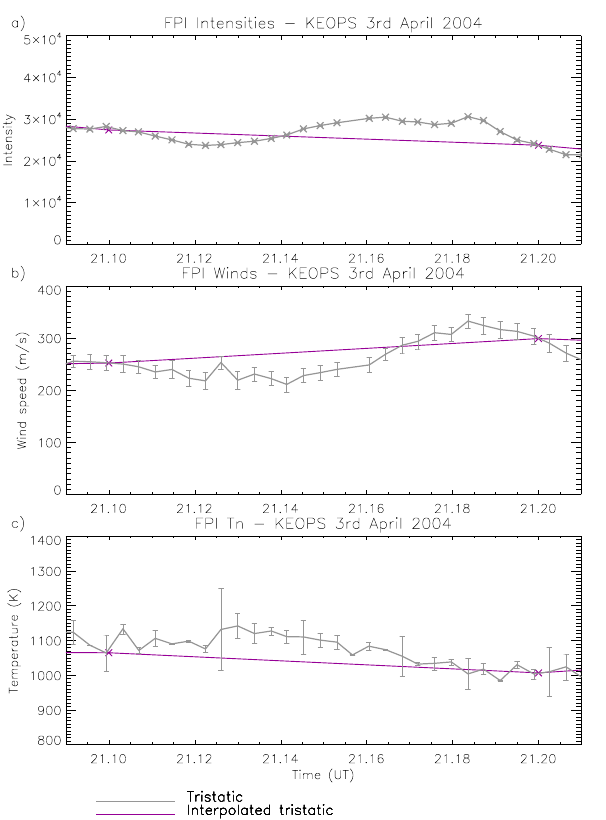
Fig. 4. 10min of high resolution FPI data from KEOPS on 3 April 2004, including 0.1h interpolated tristatic data (purple line): (a) intensities, (b) winds, and (c) temperatures.